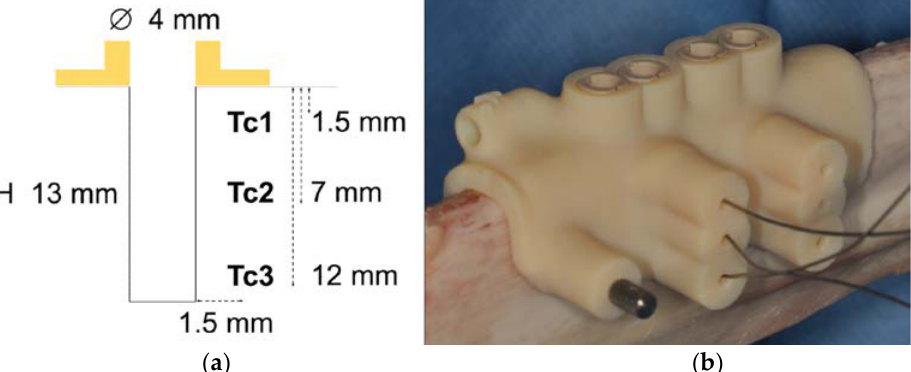
Figure 2. ( a ) Schematic drawing of the procedure. A 4.1 × 13 mm dental implant osteotomy was planned. The bone temperature was recorded at 1.5 mm from the nominal implant surface at three osteotomy depths from the bone crest: 1.5 mm (Tc1), 7 mm (Tc2), and 12 mm (Tc3). ( b ) One of the 3D-printed guides fixed on its own experimental specimen, with three thermocouples (Tc) in place.